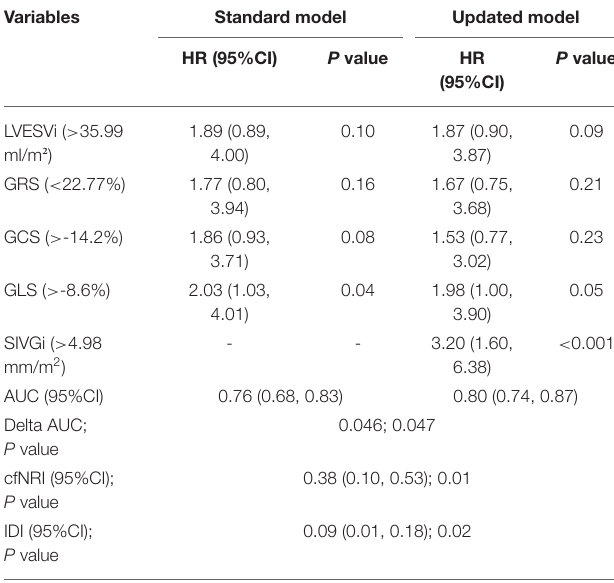
TABLE 3 | Comparison of the standard and updated multivariate Cox regression models for predicting 1-year major adverse cardiac events (MACE) post STEMI.